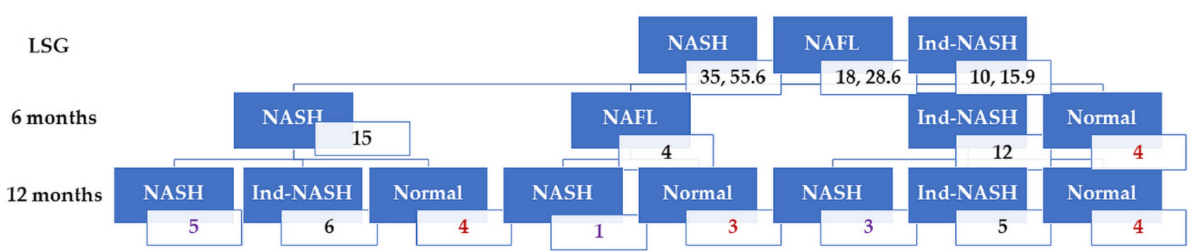
Figure 5. Patient flowcharts are shown. At 6 months after LSG, only 35 patients with NASH received liver biopsy. Four patients were able to achieve histopathological remission at 6 months after LSG. Therefore, 31 patients received liver biopsy at 12 months after LSG.